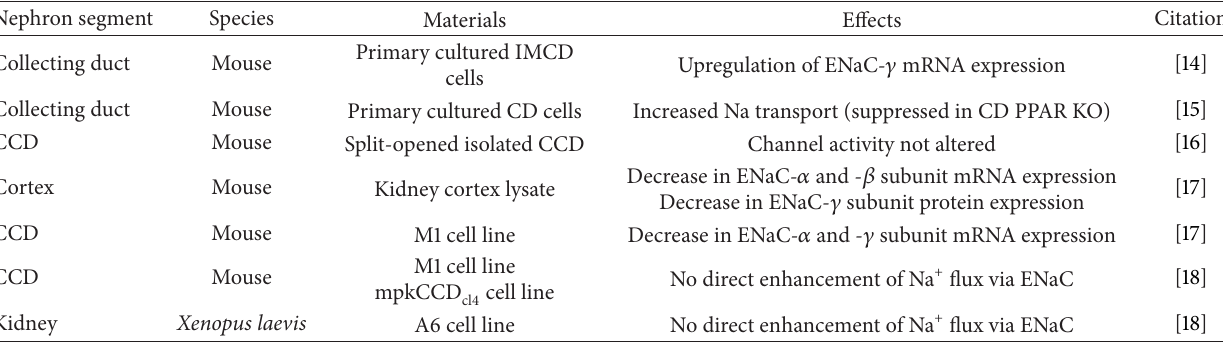
Table 2: Different effects of TZDs on